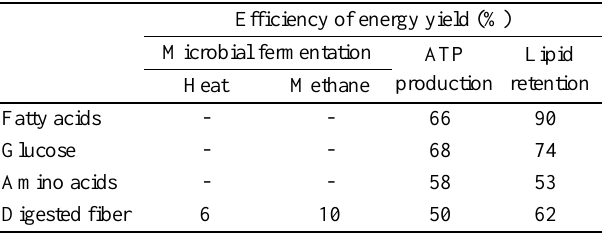
Table 1. Estimates of the energetic efficiencies with different nutrients used for ATP production or lipid retention in pigs 1 Efficiency of energy yield (%) Microbial fermentation